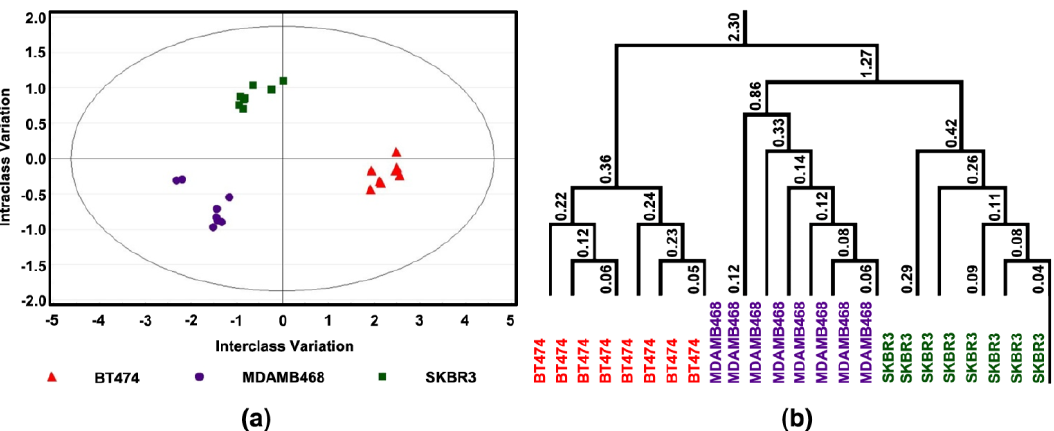
Figure 3. Effect of 4-oxo-DHA on Cell Proliferation and Apoptotic Cell Death. Levels of cell proliferation or apoptosis and associated target proteins in three human breast cancer cell lines (BT474, SKBR3, and MDAMB468); ( a ) Orthogonal projections to latent structures-discriminant analysis (OPLS-DA) shows a 3-class supervised model and partition the sources of variation; ( b ) To visualize the misclassification rate, the dendrogram depicts hierarchical clustering patterns among three different cell lines.